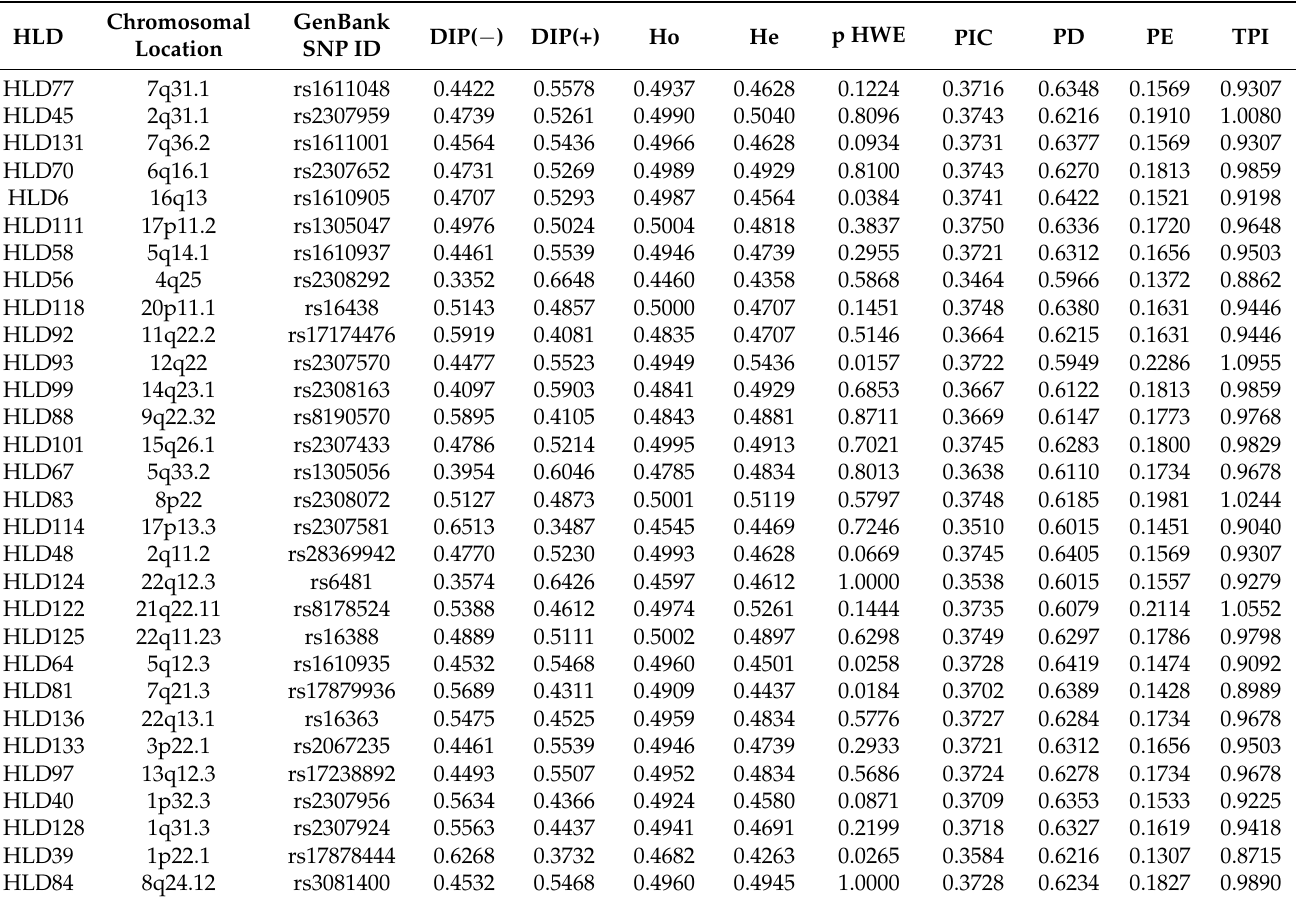
Table 1. Allelic frequencies and forensic efficiency parameters for 30 InDels in the Polish population sample ( n =